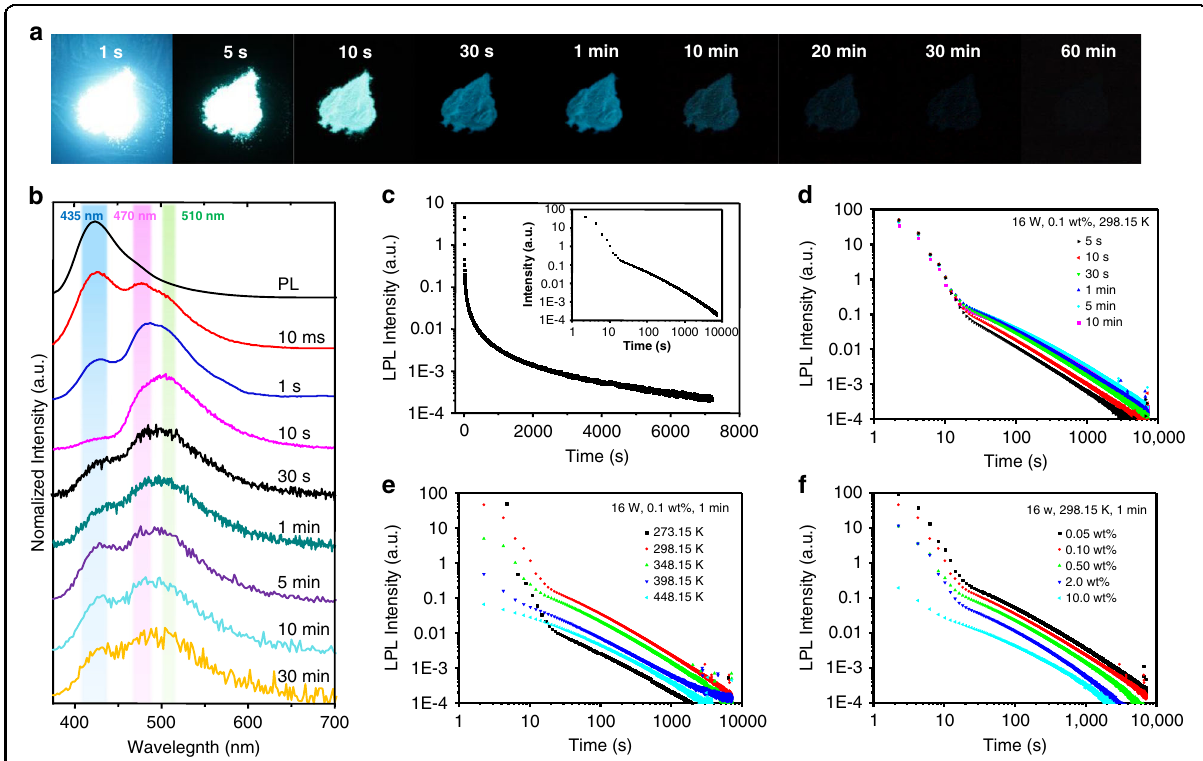
Fig. 3 The LPL properties of m-CDs@CA. a Photographs of m-CDs@CA powder (0.1 wt% sample) after the irradiation source was removed (excitation wavelength, 365 nm; excitation power, 16 W; excitation time, 1 min; temperature, 298.15K). b The photoluminescence and time-resolved afterglow spectra of the 0.1 wt% m-CDs@CA sample under ambient conditions. The colored areas highlight the range of emission wavelength maxima. c The LPL decay pro fi le of the 0.1 wt% m-CDs@CA powder (excitation power, 16 W; excitation time, 1 min; temperature, 298.15 K) and the logarithmic plot of the decay pro fi le (insert). d – f Excitation time ( d ), sample temperature ( e ), and ratio of m-CDs to urea ( f )-dependent LPL logarithmic decay pro fi